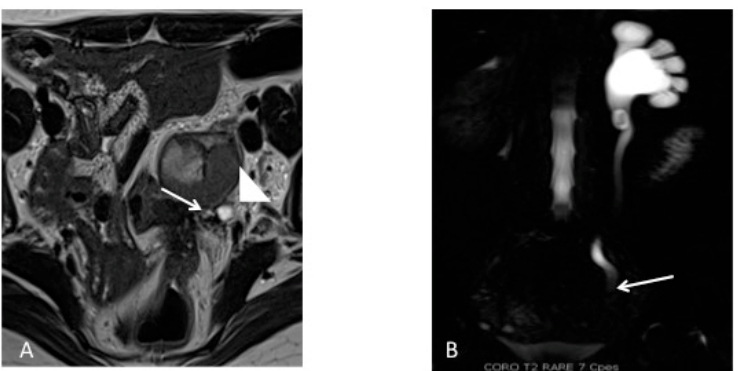
Figure 6. Magnetic resonance imaging depiction of left ureteral deep endometriosis. ( A ) Axial T2-weighted plane depicting hyposignal nodule causing stenosis of the left ureter (white arrows), which appears dilated and is confirmed on the ( B ) magnetic resonance urography in the coronal HASTE T2